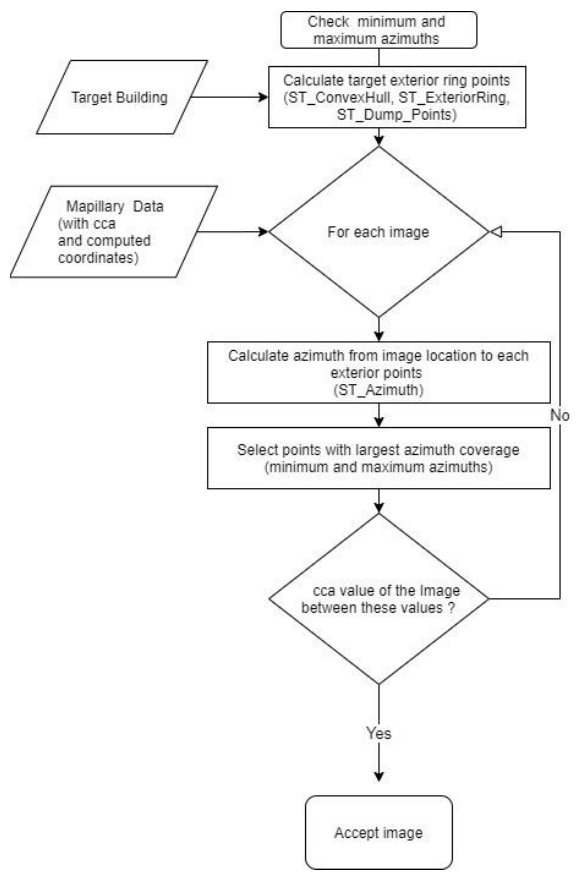
Figure 5. Process flow for checking the minimum and